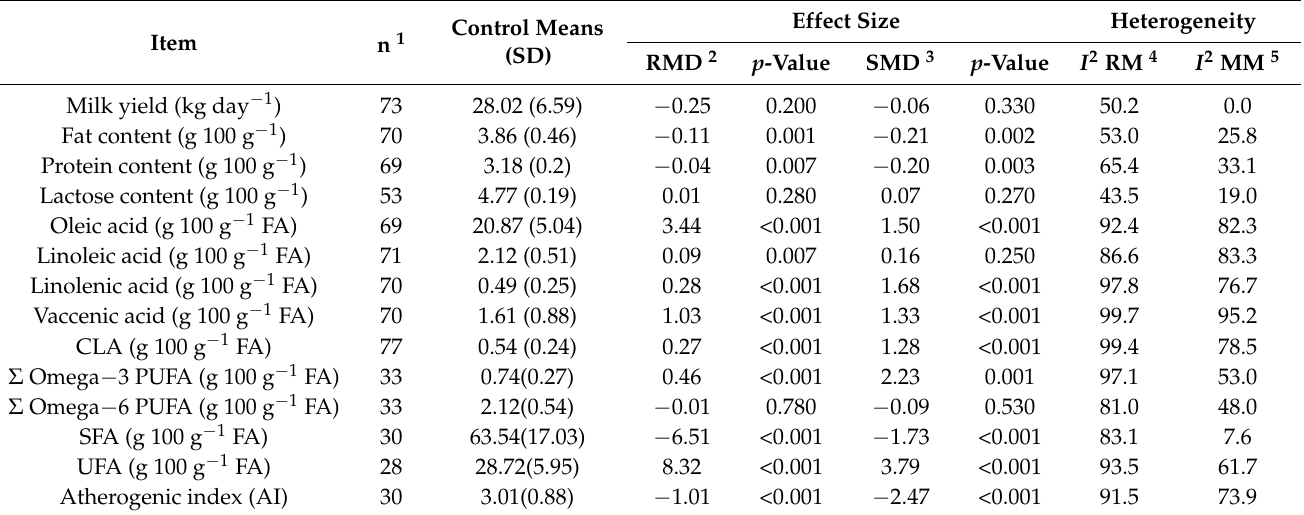
Table 2. Effect of oilseed inclusion on milk yield, chemical composition and fatty acid profile of dairy